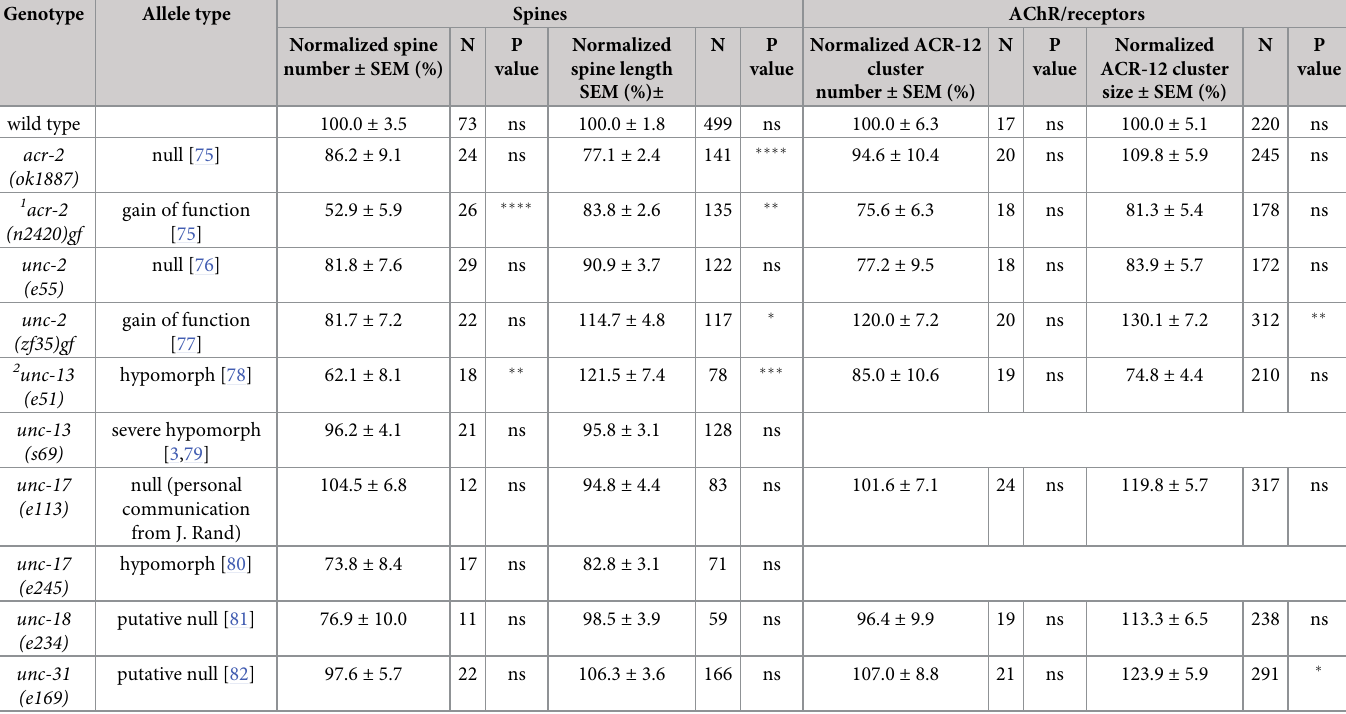
Table 1. Analysis of dendritic spines and cholinergic receptors in mutant strains with altered synaptic activity. Dendritic spine number, spine length, ACR-12/AChR cluster number, and AChR cluster size at L4 stage normalized to the same measurements from wild type are shown (mean ± SEM) for each genotype (ACR-2/nAChR UNC-2/CaV2 α , UNC-13/MUNC-13, UNC-17/VAChT, UNC-18/MUNC-18, UNC-31/CAPS). Mutations that affected synaptic activity had little effect on the density of spines or AChR clusters, but had variable effects on spine length and AChR cluster size. One-way AVOVA, Dunnett’s multiple comparisons test, � p < 0.05, �� p < 0.01, ��� p < 0.001, ���� p < 0.0001.